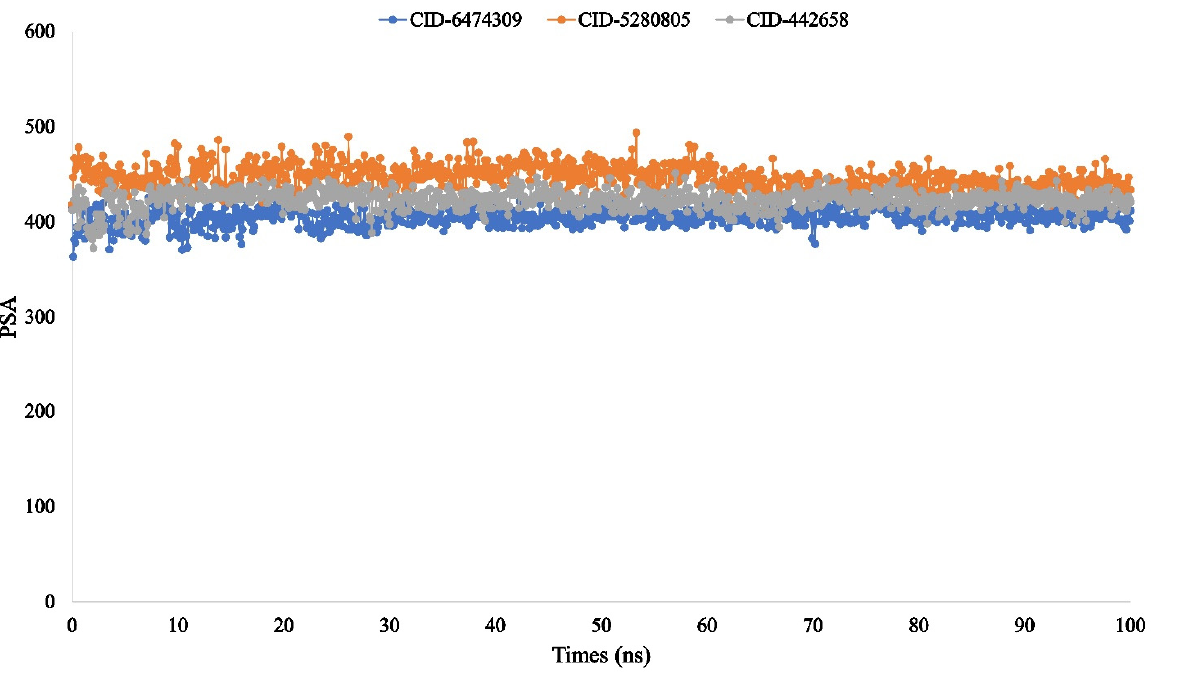
Figure 12. The polar surface area (PSA) of the protein–ligand interaction compounds was calculated from the 100 ns simulation interaction diagram. The selected three ligands compound 4,5-di- O - Caffeoylquinic acid (CID-6474309), rutin (CID-5280805), and schaftoside (CID-442658) in association with the selected protein are depicted by green, orange, and grey, respectively.